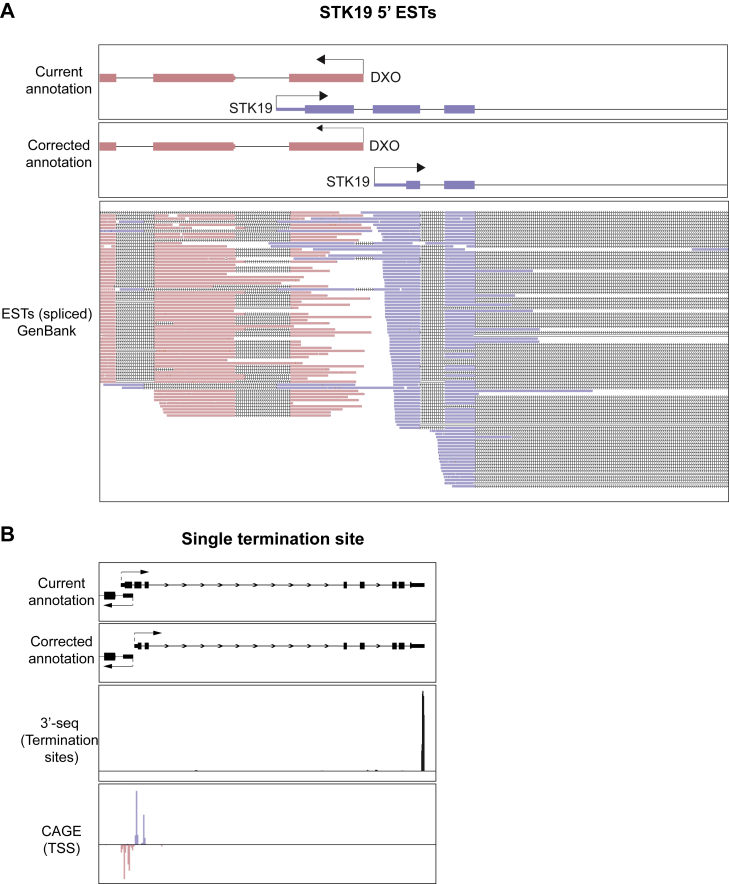
STK19 ESTs and Termination Site, Related to Figure 1(A) Genome browser view of STK19’s 5′ region. Current annotation and corrected annotation are aligned to spliced GeneBank ESTs. The reverse strand gene (DXO) and ESTs are shown in pink, and forward gene (STK19) and ESTs are shown in blue. The few ESTs upstream of the corrected annotation likely originate from transcriptional readthrough of SKIV2L or from promiscuous transcription of the locus. (B) Genome browser view of STK19, with current and corrected annotations shown aligned to transcription termination sites, mapped by 3′-seq in HEK293 cells (Gregersen et al., 2019), and transcription start sites (TSSs) mapped by CAGE by in the FANTOM database. Forward TSS are shown in blue and positive and reverse TSS in pink and negative.